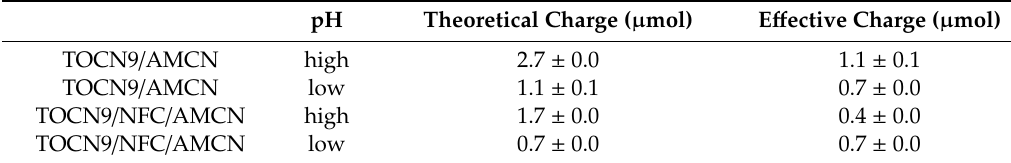
Table 4. pH stimulus, theoretical and e ff ective charges of TOCN9 / AMCN and the TOCN9 / NFC / AMCN